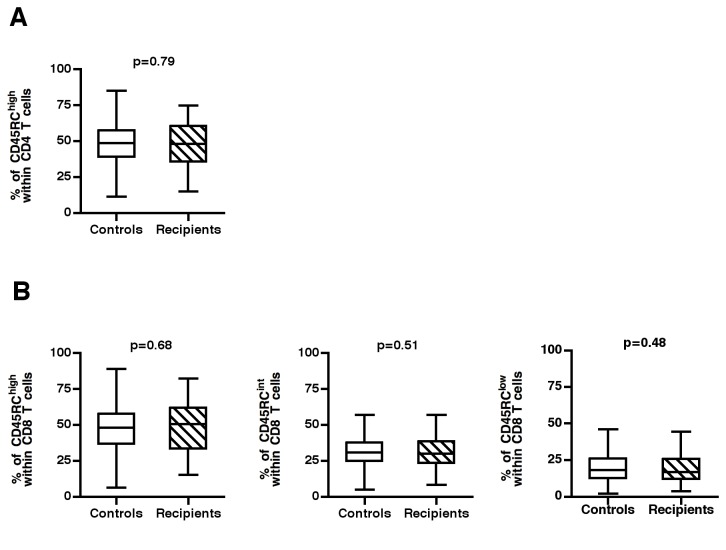
Distribution of CD45RC T cell subsets in the studied cohort compared to healthy individuals.Peripheral blood leucocytes from 89 patients were frozen in liquid nitrogen before renal transplantation. Thereafter, these cells were thawed and stained with mAbs against TCR, CD4, CD8 and CD45RC. (A, B) the proportion of CD45RC subsets within CD4 (A) and CD8 T cells (B) in the 89 recipient before the graft were compared to those of 608 healthy individuals. The p-values were calculated using the Mann-Whitney test.